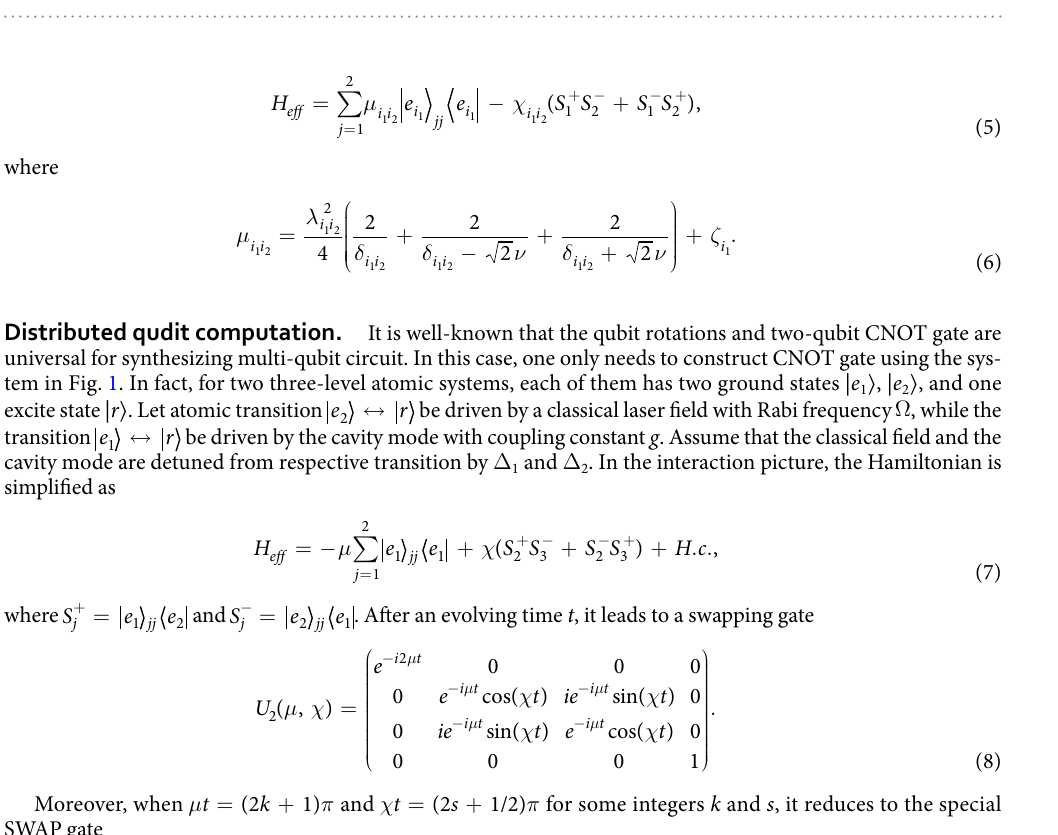
Figure 2. The circuit decomposition of the CNOT gate using the iSWAP gate and single qubit gates. H denotes the Hadamard gate. Z denotes the Pauli phase flip gate. R z ( θ ) denotes the rotation along the z -axis on the Bloch sphere with the angle θ while Ph ( θ ) denotes the global phase gate with angle θ